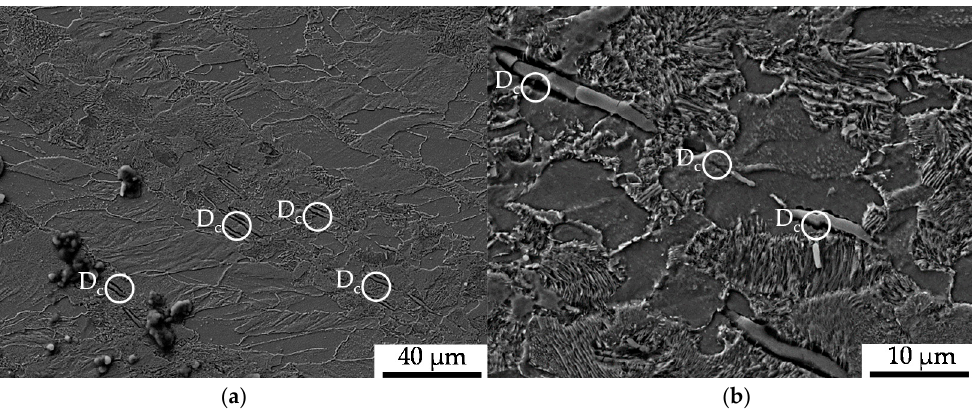
Figure 8. Cyclic damage (D c ) induced under cyclic compression load paths in the bulged area of the material: ( a ) overview of the ferrite–pearlite microstructure; ( b ) detailed view of the interface decohesion between the metallic matrix and MnS-inclusions.